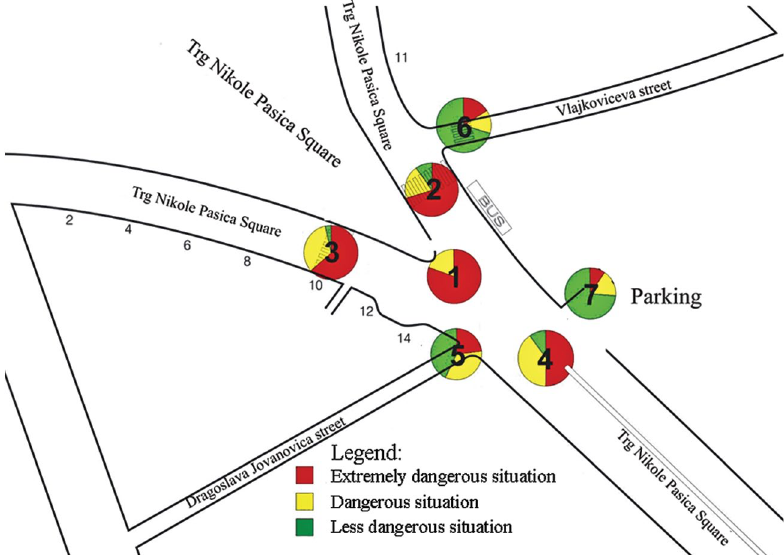
Fig. 6. Danger spots from the aspect of subjective assessments of participants in traffic (Vujanić et al.